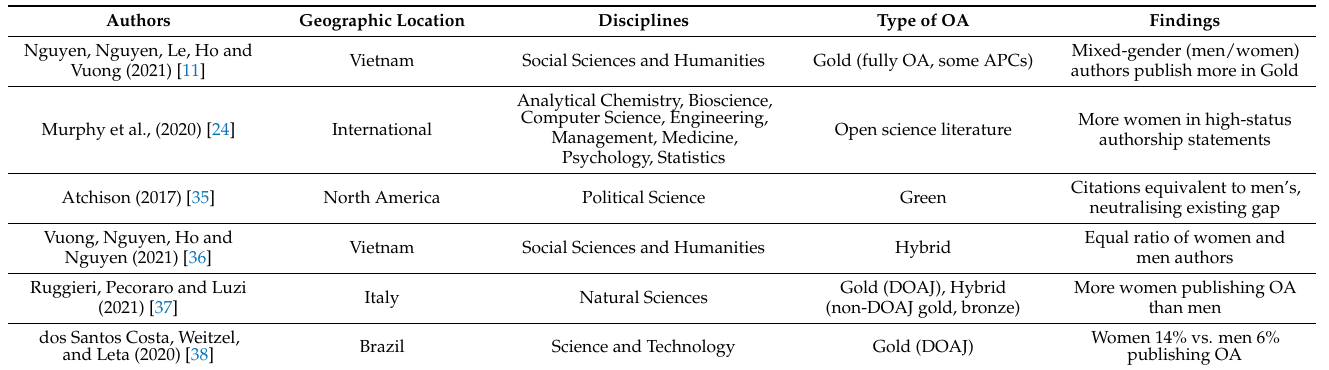
Table 1. Examples in the literature of open access publishing by women academic researchers counteracting the predominant deficit